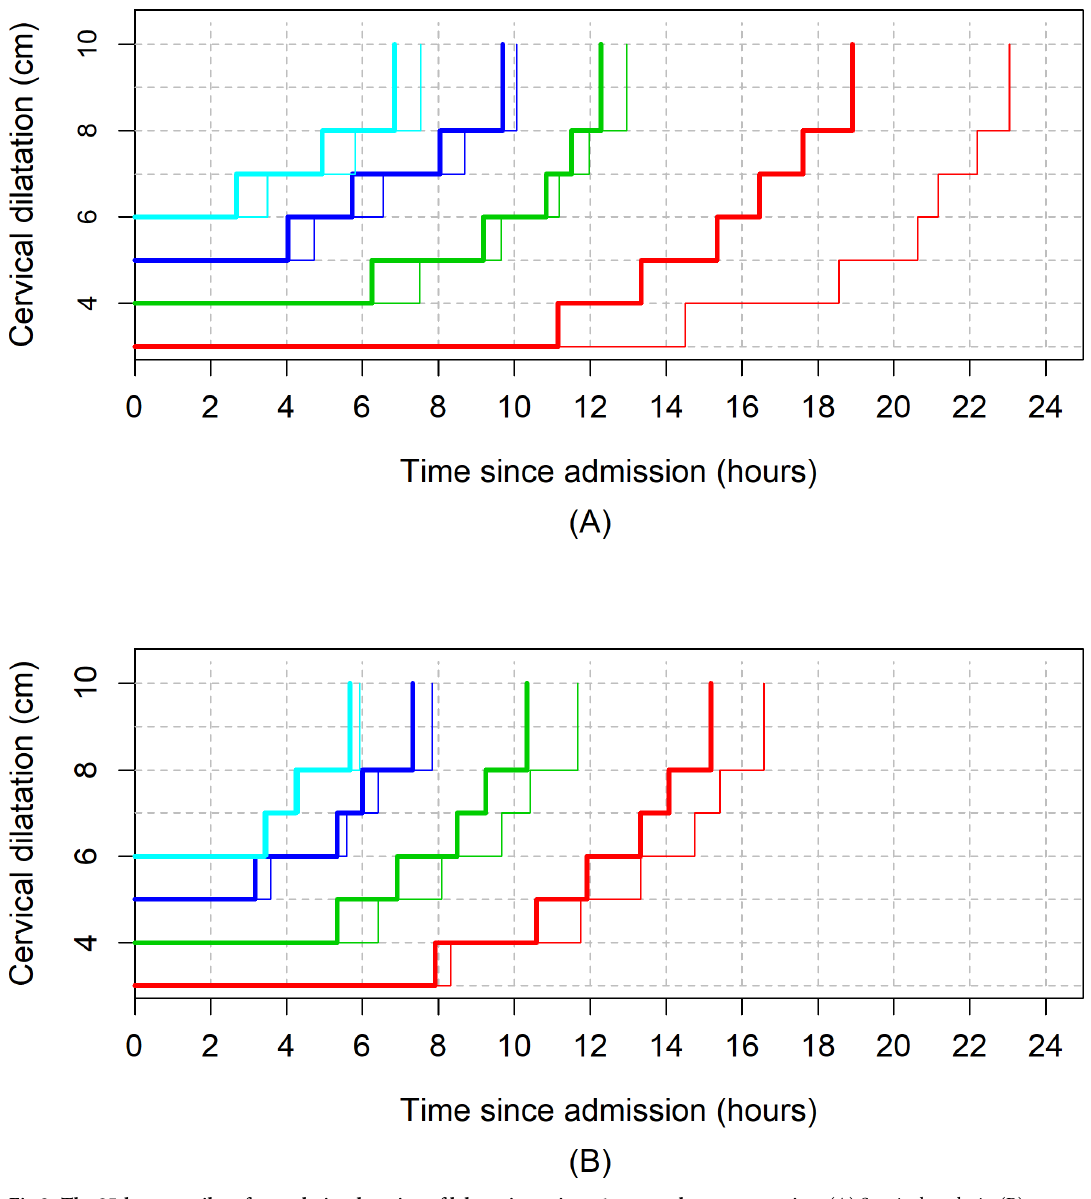
Fig 8. The 95th percentiles of cumulative duration of labour in parity = 1 women by augmentation. (A) Survival analysis. (B) Multistate Markov analysis. Thin lines: all women. Thick lines: women with oxytocin augmentation excluded.